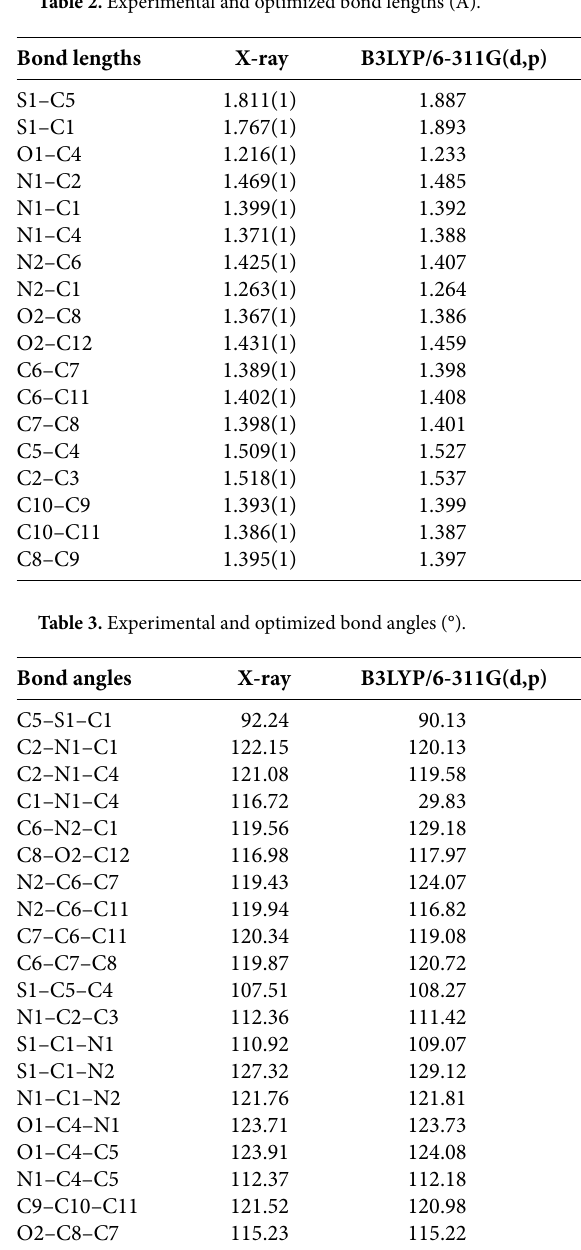
Table 2. Experimental and optimized bond lengths (Å).